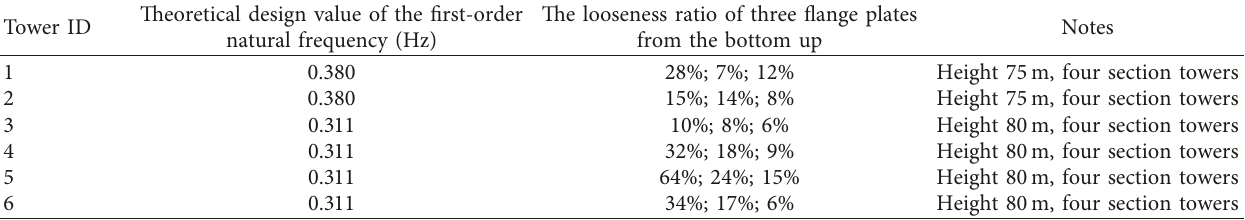
Table 1: The bolt looseness ratio statistics of the six wind turbine